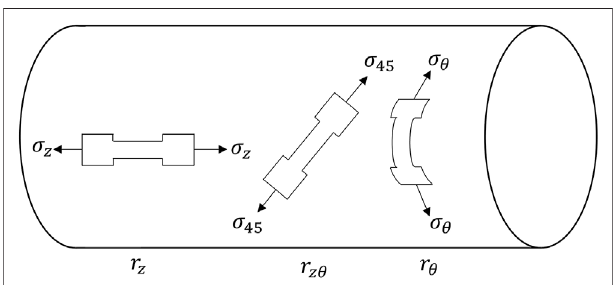
FIGURE 1 | Directions of the anisotropy coef fi